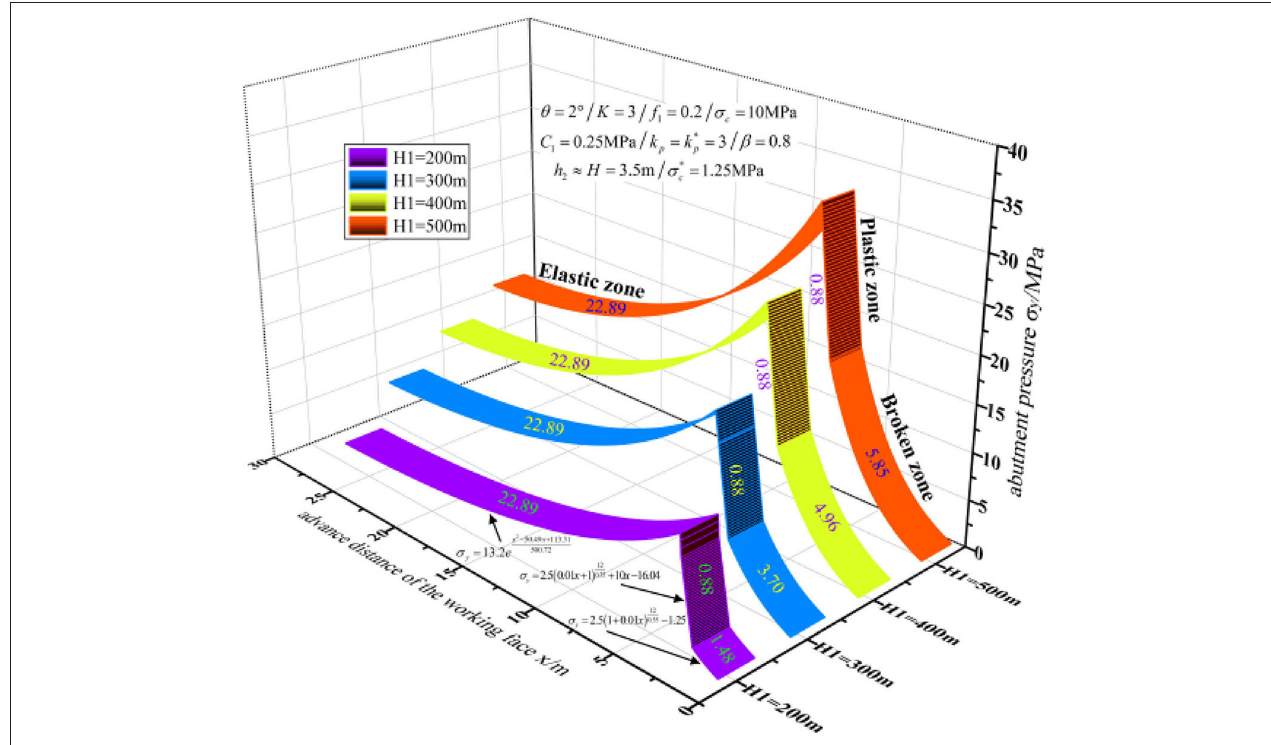
FIGURE 4 | Impacts of mining depth on abutment pressure.